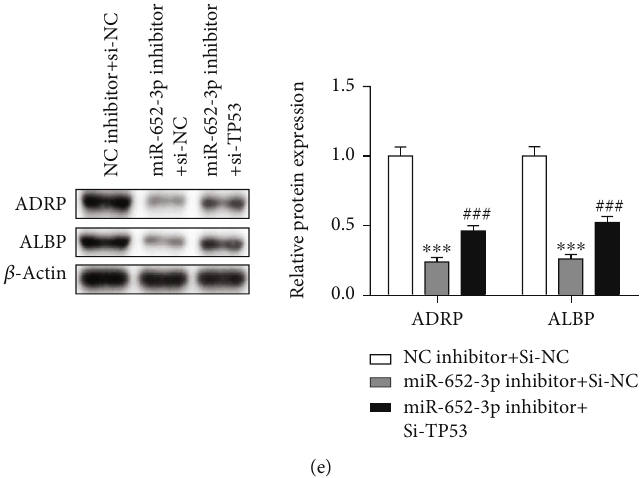
Figure 6: Si-TP53 rescued the e ff ect of miR-652 inhibitor in AS. (a) miR-652-3p inhibitor decreased the expression of proin fl ammatory cytokines, while si-TP53 rescued the expressions. (b) Foam formation. (c) Cholesterol accumulation in ox-LDL-treated macrophages. (d) Western blot assay for PPAR α and CRT1 protein expressions. (e) Western blot assay for ADRP and ALBP protein expressions vs. NC inhibitor +siNC group, ∗∗∗ P < 0 : 001 vs. miR-652-3p inhibitor +si-NC group, ### P < 0 : 001